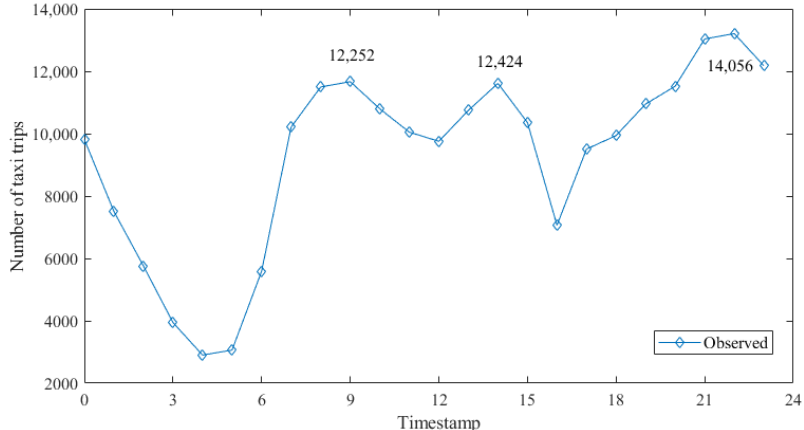
Figure 3. Hourly average taxi ridership of Xiamen Island.